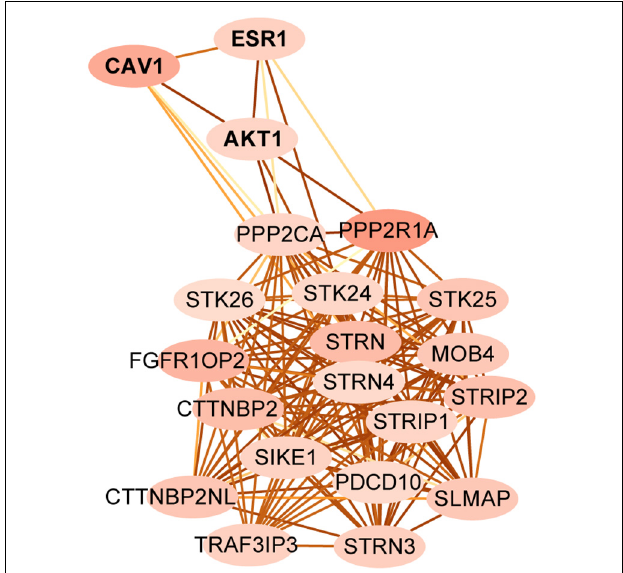
FIGURE 4 | The protein-protein interaction subnetwork between STRIPAK genes and different expression level of proteins between LIHC and KIRC. Map node color to indegree, and low values to brighter colors. Map edge color to the combined_score, which means edges with lighter color have fewer protein-protein associations.